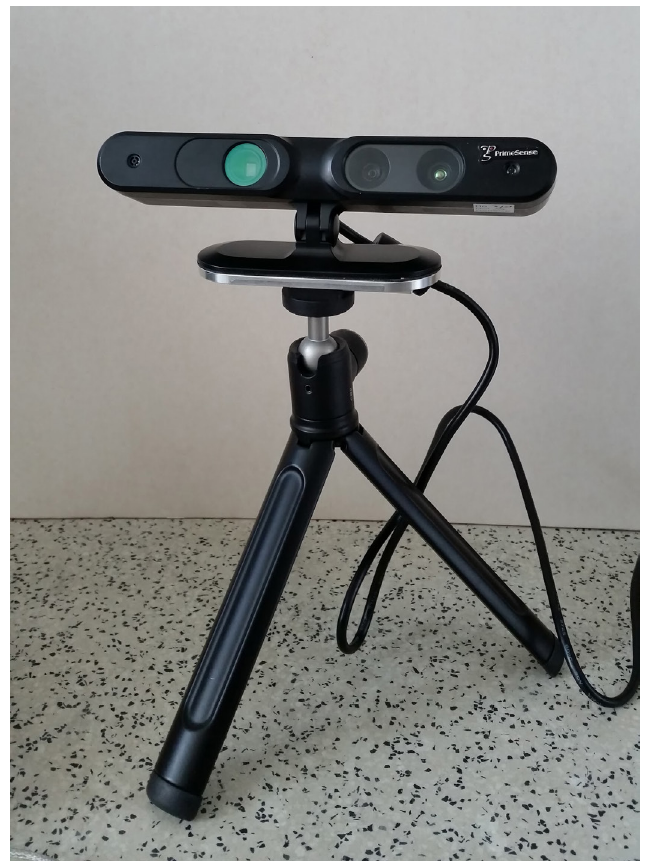
Fig. 3.34. The Primesense infrared depth sensor of the Gotcha with a tripod, allowing it to stand or be used handheld while